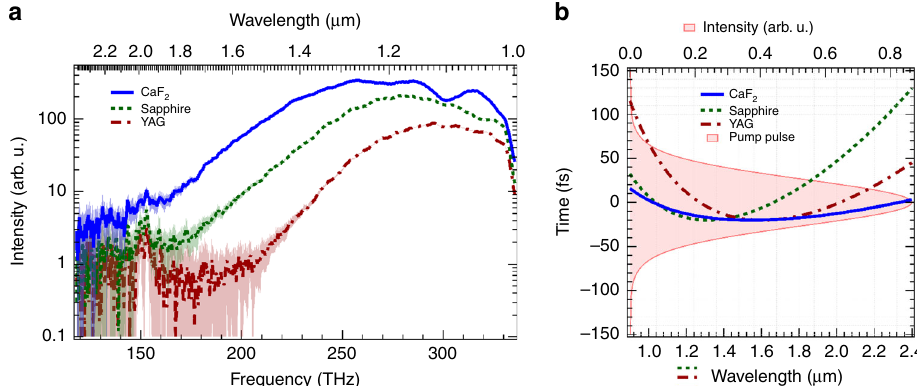
Fig. 8 White-light generation. a White-light spectra generated from a 3-mm CaF 2 (blue solid curve), a 3-mm sapphire (green dotted curve), and a 3-mm YAG (brown one dot chain curve). The shaded area are error bars estimated from the statistics of the measured spectra and backgrounds. b Calculated group delay introduced by the CaF 2 (blue solid curve), the sapphire (green dotted curve), and the YAG (brown one dot chain curve). The pump pulse pro fi le calculated under the Fourier limit condition is depicted with the shaded